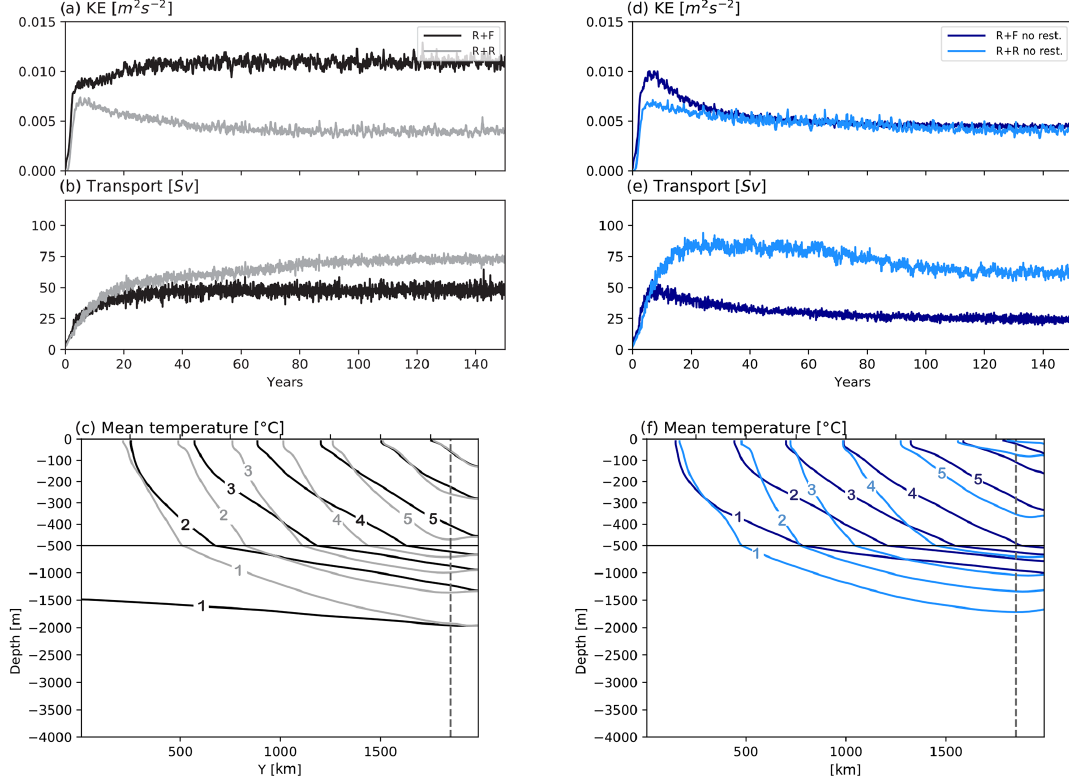
Figure 5. The 150-year time series of (a, d) domain-averaged total kinetic energy (units: m 2 s − 2 ) , (b, e) transport (units: Sv) and (c, f) sections of zonally averaged mean temperature for the last 10 years of the simulations (contours ranging from 1 to 7 ◦ C). Simulations with restoring at the northern boundary (R + R and R + F) are shown in (a) and (c) , and simulations without restoring (R + Rnr and R + Fnr) are shown in (b) and (d) . In (c) , the vertical dashed line indicates the limit of the restoring zone at the northern boundary.